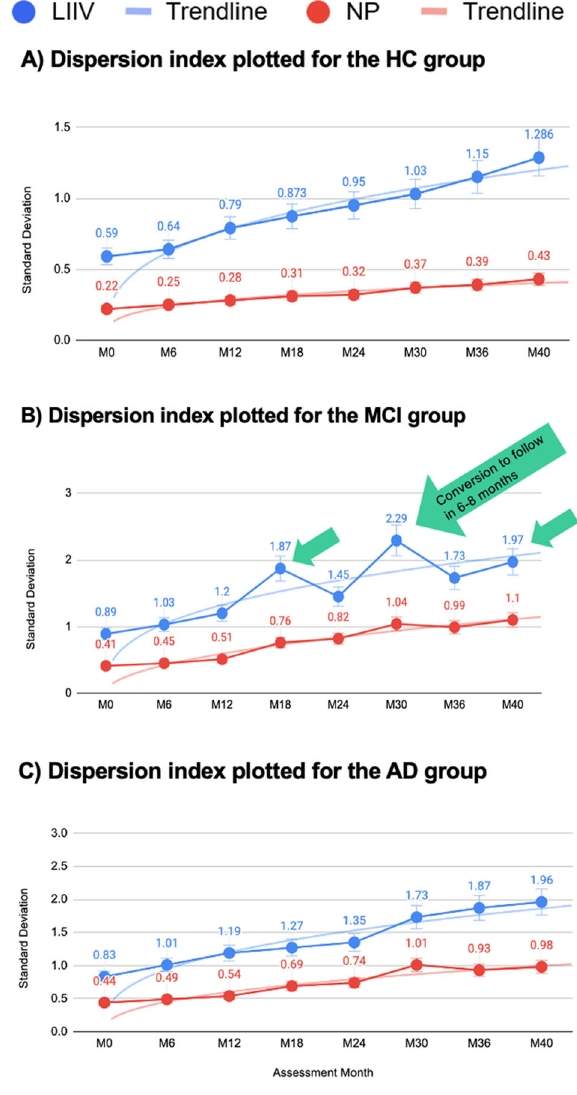
Fig. 3 Dispersion index plotted across tasks, showing group intraindividual standard deviation (iSD) for the HC ( A ), MCI ( B ), and AD ( C ) groups. The A – C graphs show a nonlinear increase in SD as a function of disease trajectories. IIV is consistently and signi fi cantly more sensitive for the disease trajectory trends than conventional NP assessments, especially at the pre-conversion events (spikes in B predict a likely conversion by next assessment). LIIV longitudinal In the context of AD, dispersion has been shown to be a sensitive marker to detect change in cognition and functional abilities even at prodromal stages of the disease 3,23 – 25 . Establish- ing meaningful change at the level of an individual is instrumental, as signi fi cant effects in group-level statistics do not show (and cannot even imply) what changes have occurred for any one individual 26 . Taking both of these facts into account, we analyzed dispersion differences between a full 120 – 140 min conventional NP assessment with 13 cognitive domains and the 10 min Altoida DNS assessment with 11 cognitive domains, and compared the dispersion in a group of HC, MCI, and AD participants over 40 months. The Altoida DNS showed consistently and signi fi cantly higher sensitivity in capturing these changes for disease trajectory trends. This was particularly true at later stages of the disease, as shown in LTRS/LDVS results (Fig. 2 and Table 1),